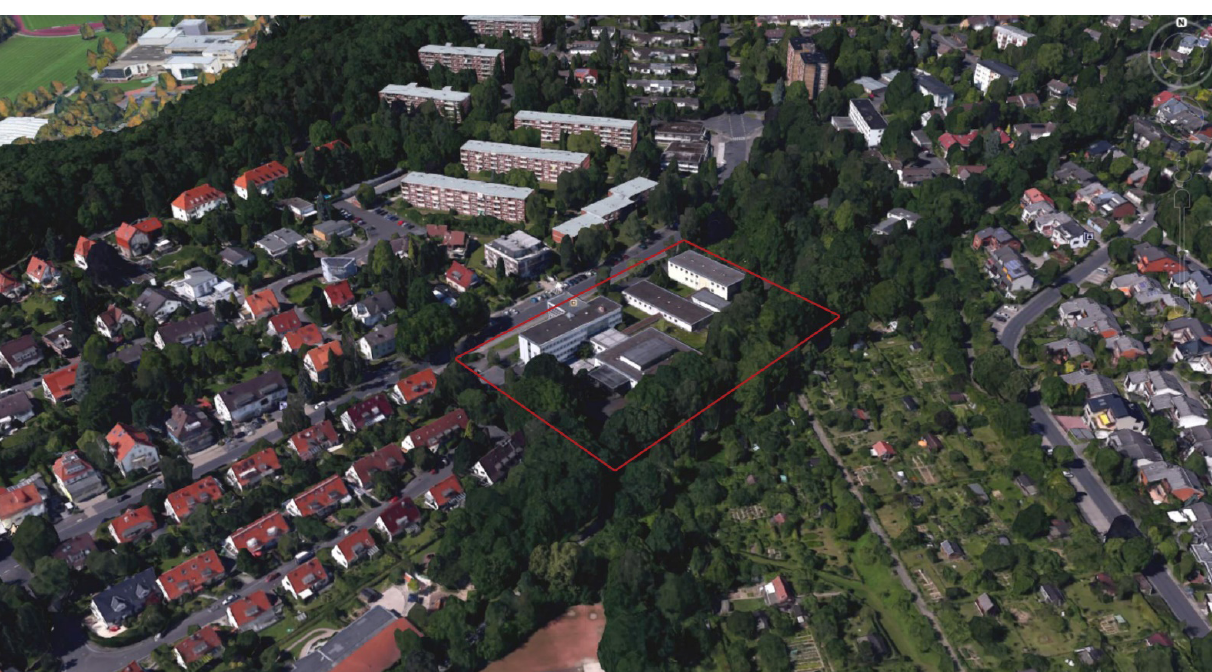
Figure 4. Former institute transformed into accommodation for 200 asylum-seekers in 2015. The accommodation, located in a residential neighborhood, enjoyed high engagement of neighbors and volunteers before it was closed. Source: author. Aerial view retrieved from Google Earth on 31 October 2018.